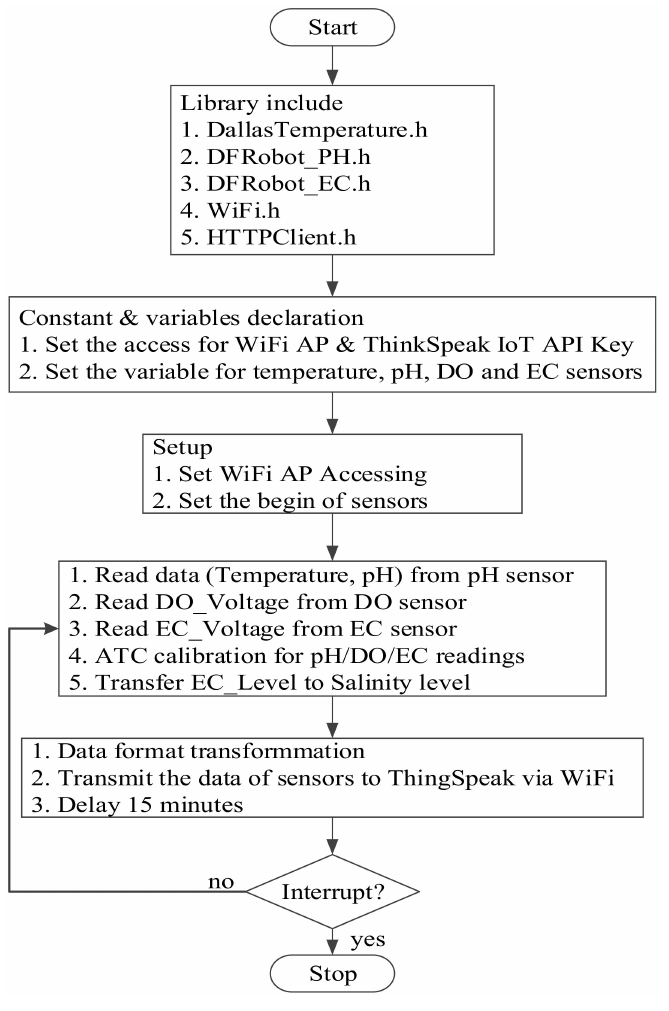
Figure 6. Flowchart of wireless multi-sensor